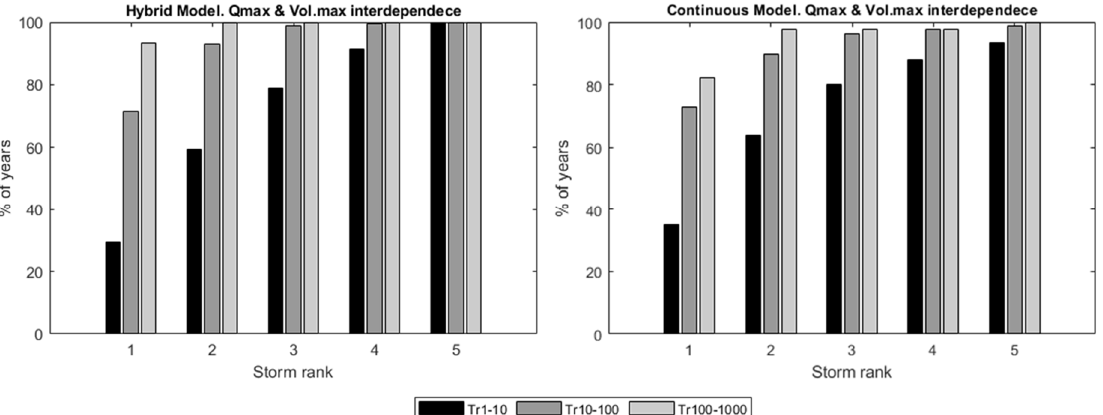
Figure 11. Percentage of years (from a total of 5000 years) where the annual peak-flow and maximum annual hydrograph volume are identified by considering different storm ranks and classified according to different Tr ranges. Left graph corresponds to the hybrid model and the right one to the continuous one. Black bars show the events ranging between 1 and 10 years return period (Tr), grey bars between 10 and 100 years and the light grey bars between 100 and 1000 years.